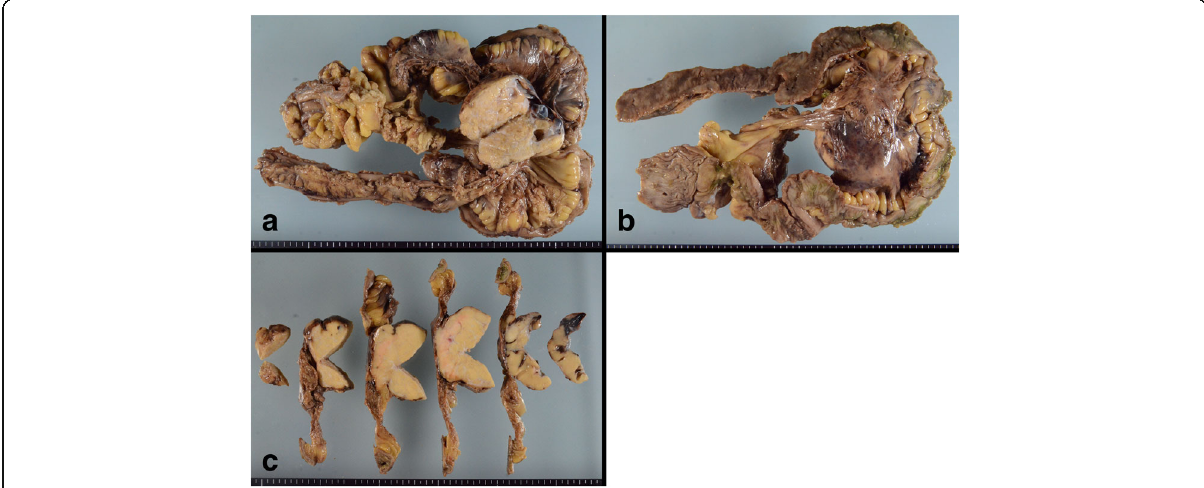
Fig. 2 Macroscopic findings of the mesenteric tumor. a , b Nodular and well circumscribed tumor in the mesentery. c The cut surface of